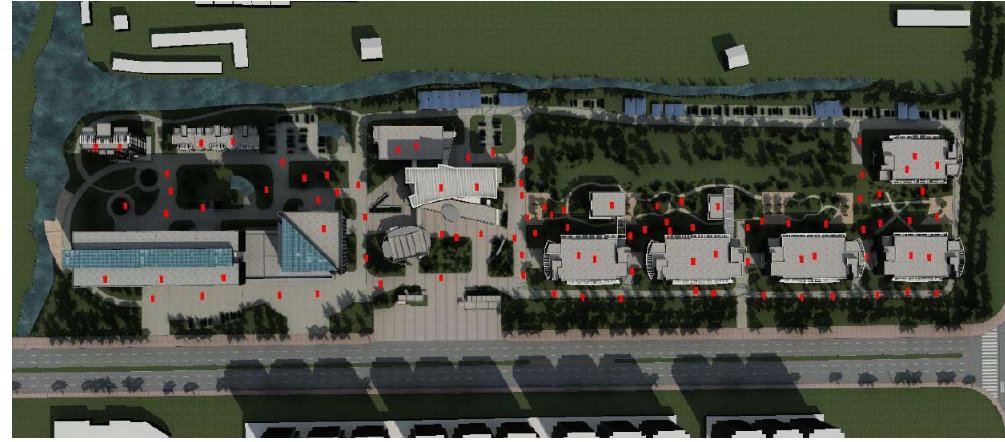
Figure 16. Sample locations used for comparison of annual global radiation with SURFSUN3D.